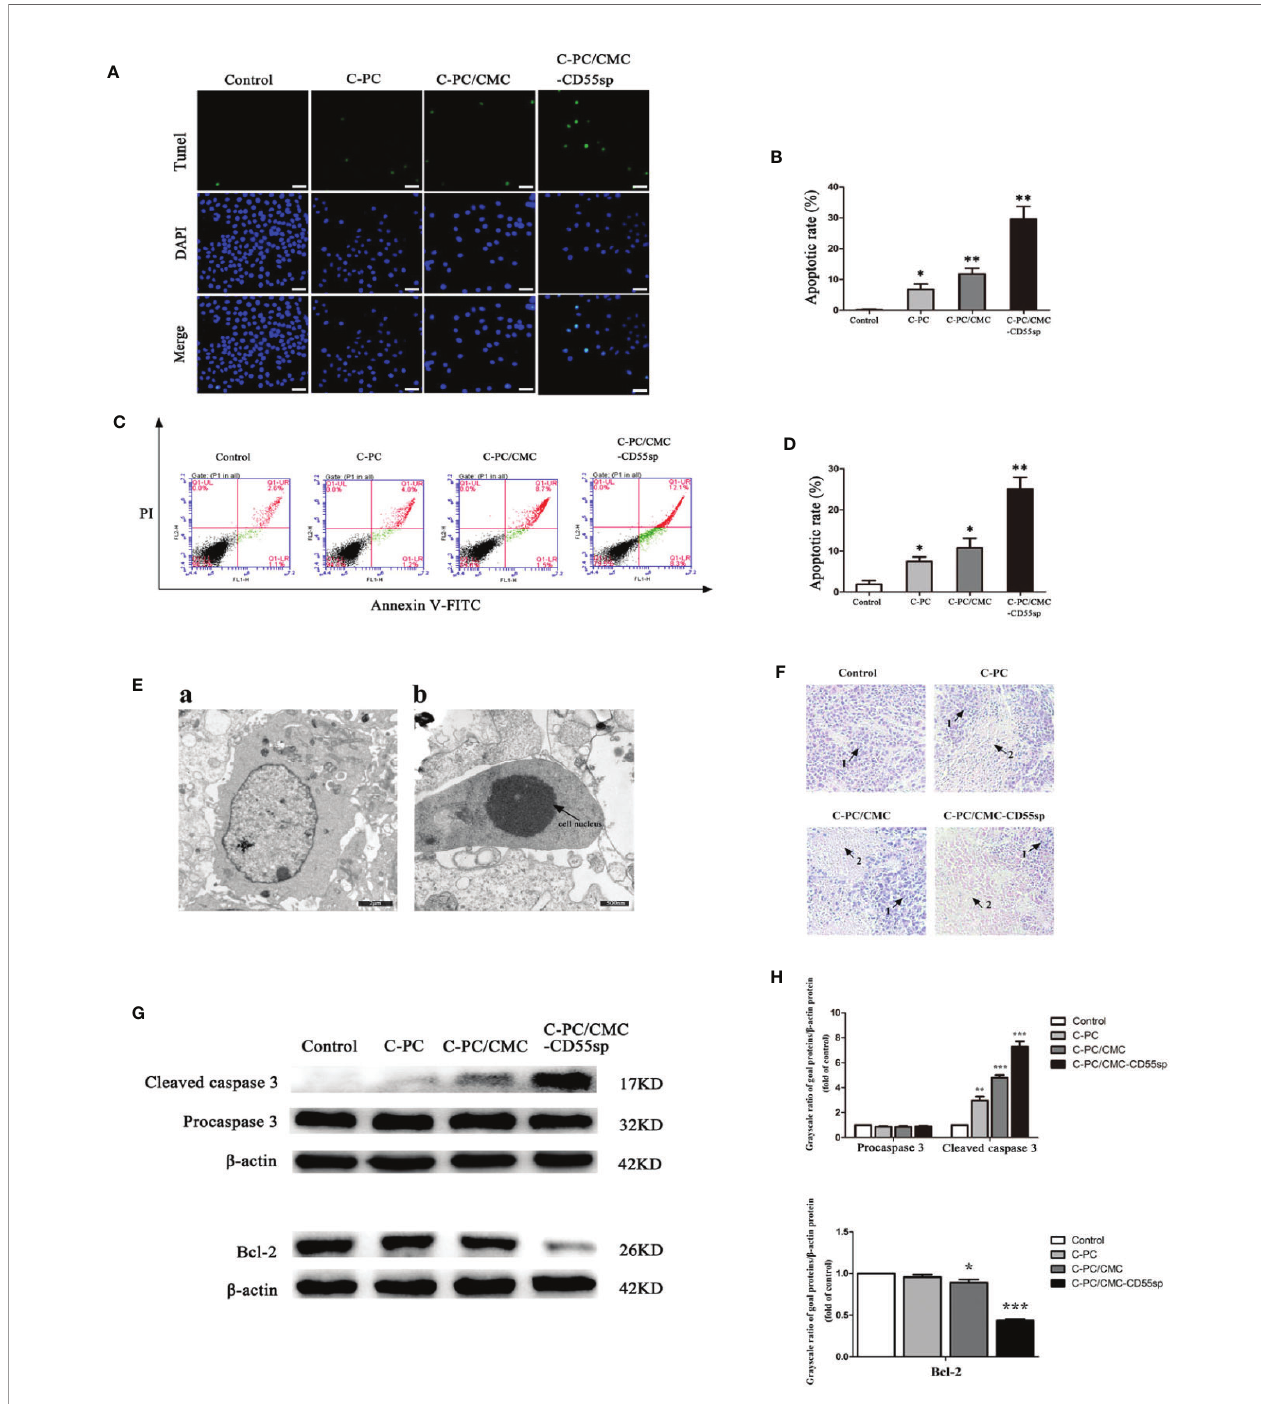
FIGURE 5 | Drug-induced apoptosis. (A, B) TUNEL assay. Blue fl uorescence indicates nuclei, and green fl uorescence indicates apoptotic cells. The percentage of apoptotic cells (%) was equal to the ratio of the number of stained cells to the total number of cells. Results are expressed as the mean ± SEM (n = 3). *P < 0.05, **P < 0.01. Scale bars, 20 m m. (C, D) Flow cytometry analysis. Apoptosis was evaluated using an annexin V-FITC and PI apoptosis detection kit. The apoptosis rates of cells were determined, and C-Phycocyanin (C-PC)/CMC-CD55sp nanospheres induced apoptosis to the greatest extent. Results are expressed as the mean ± SEM (n = 3). *P < 0.05, **P < 0.01. (E) Electron microscopy. a. Normal HeLa cells. Scale bars, 2 m m; b. Apoptotic HeLa cells. Scale bars, 500 nm. Arrows indicate nuclei. (F) Hematoxylin and eosin staining. (1) Normal HeLa cells; (2) apoptotic HeLa cells. (G, H) Western blot. Protein levels were normalized to b -actin. Results are expressed as the mean ± SEM (n = 3). *P < 0.05, **P < 0.01, ***P <